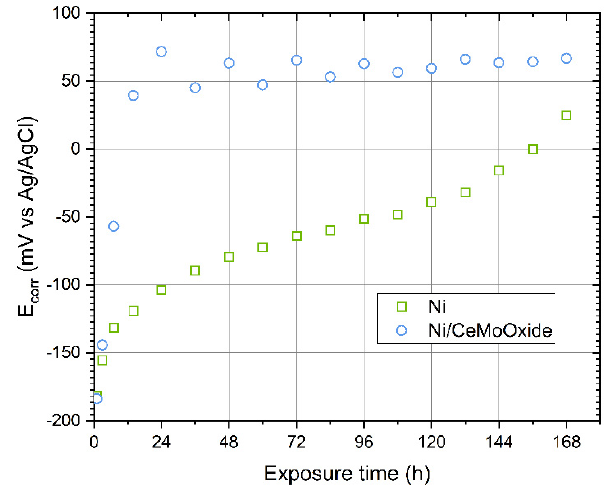
Figure 4. Polarization resistance ( R p ) recorded for blank and composite Ni coatings during 168-hour exposure in 0.05 M NaCl solution.